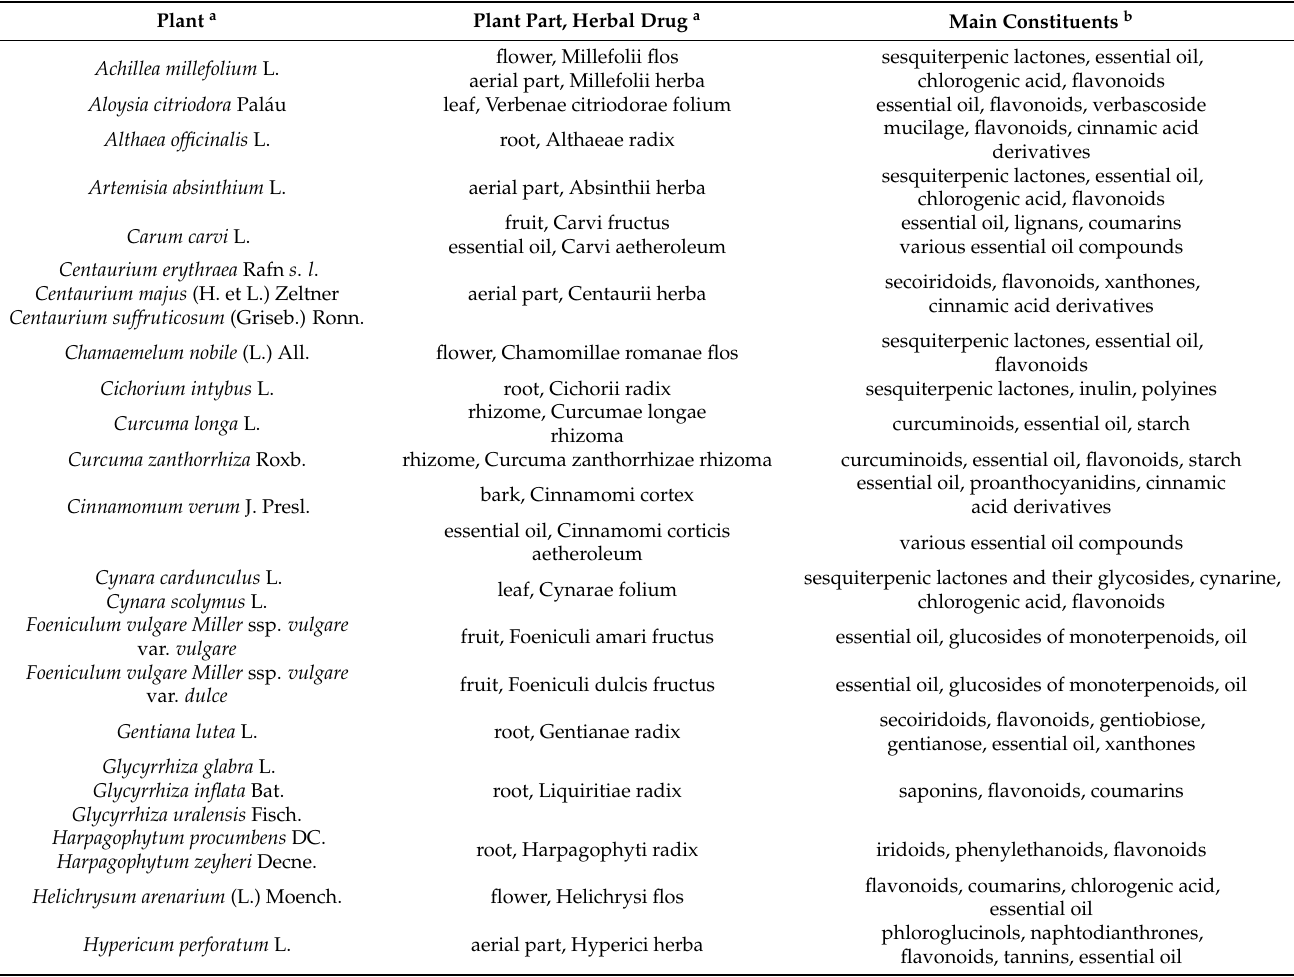
Table 3. Herbal drugs and related essential oils used for mild dyspepsia treatment